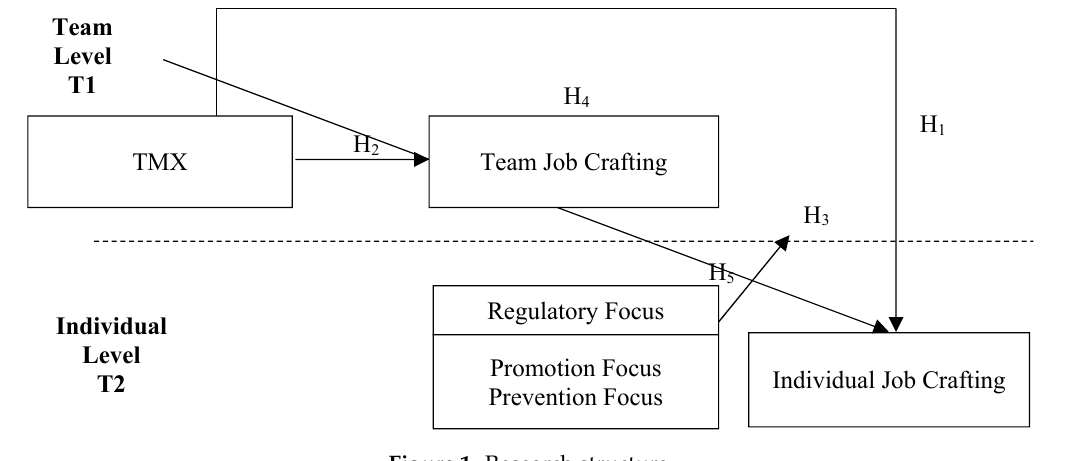
Figure 1. Research Figure 1. Research structure.